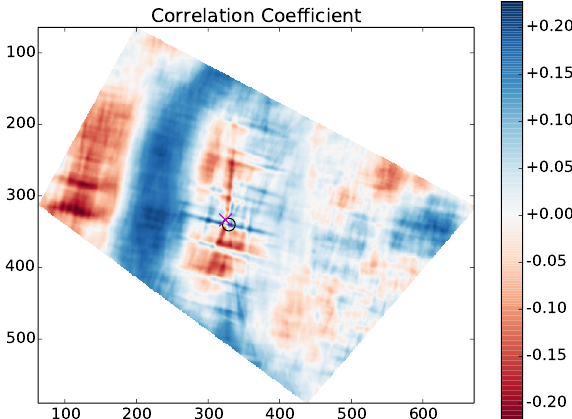
Figure 6: Correlation coefficients for all possible displacements with full overlap of the OPM detail (see fig. 5) w.r.t. the UP (see fig. 2), with the maximum value being marked by a black circle, close to the correct position (magenta